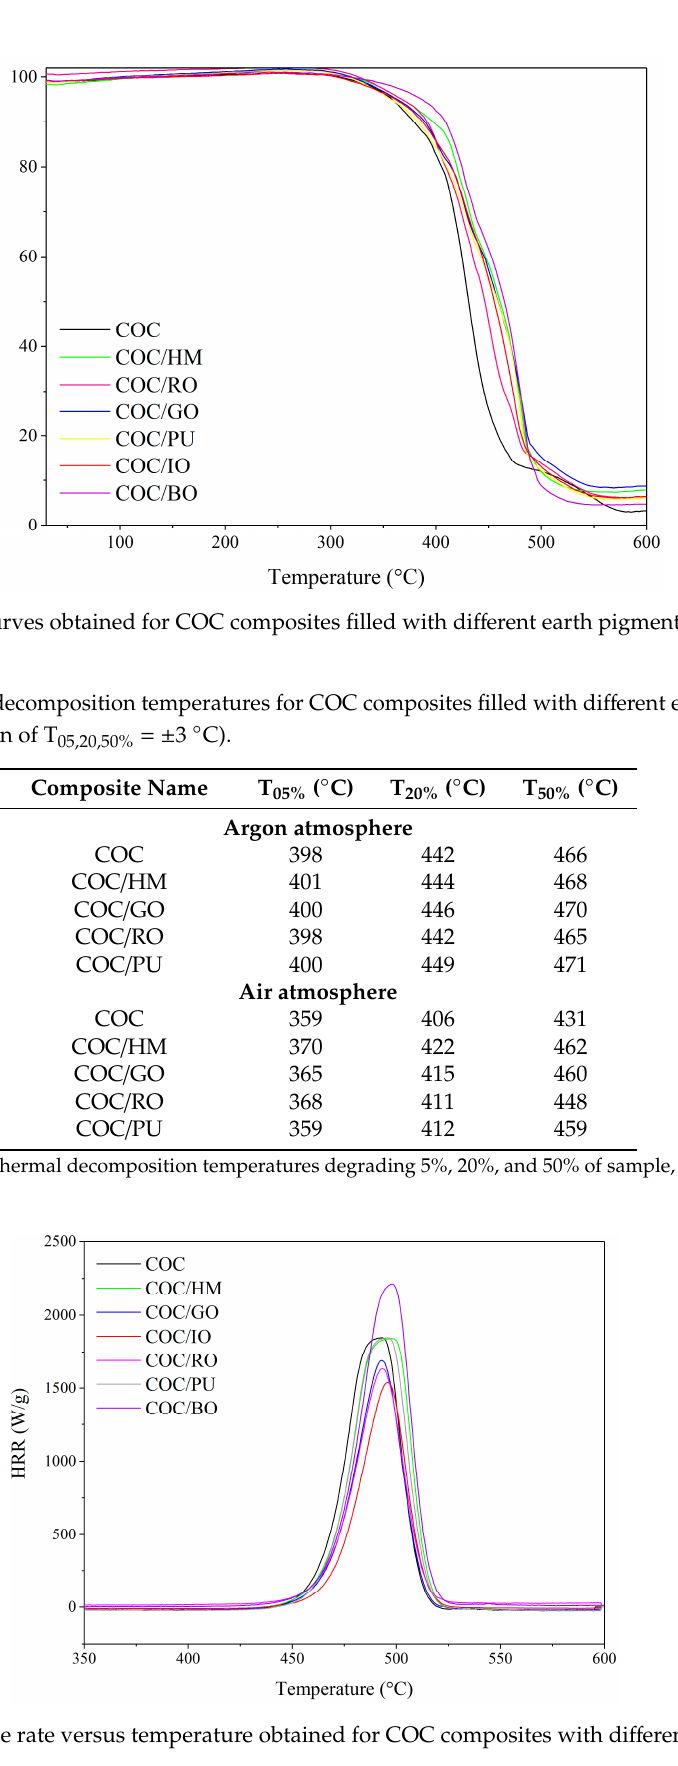
Figure 11. Heat release rate versus temperature obtained for COC composites with different earth pigments.